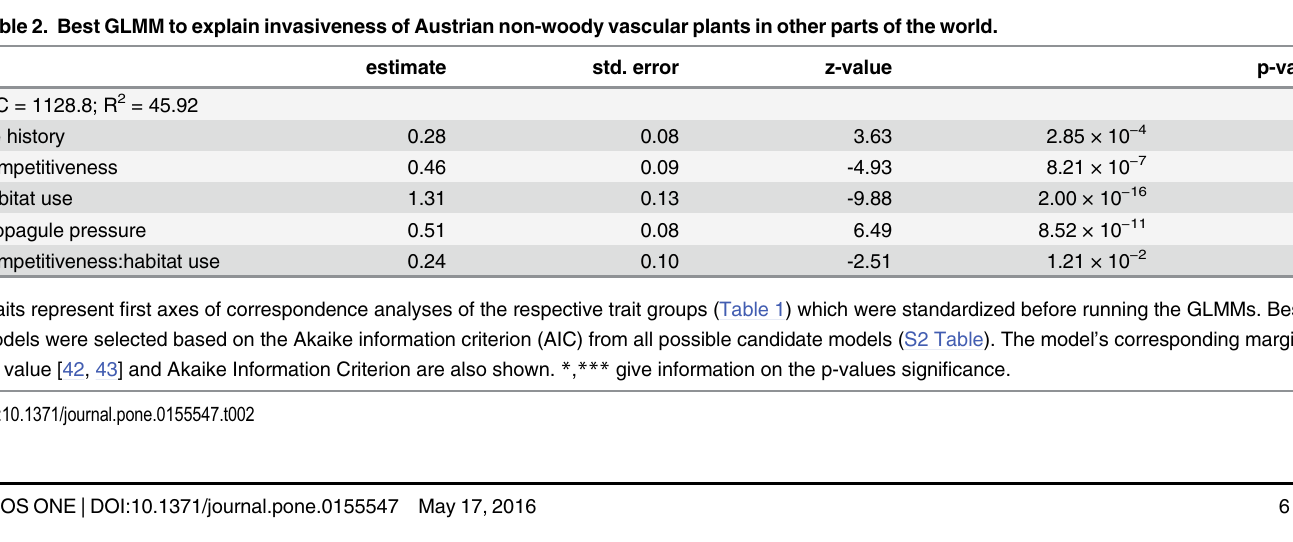
Table 2. Best GLMM to explain invasiveness of Austrian non-woody vascular plants in other parts of the world. estimate std. error